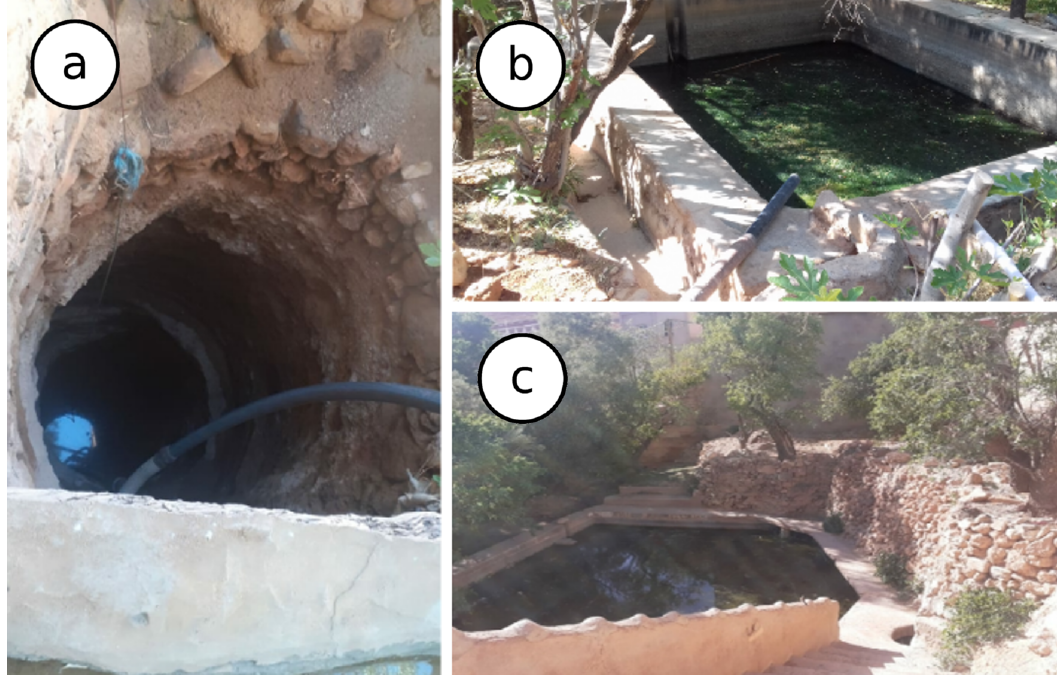
Figure A3. Nodes of the irrigation system. ( a ) A well with mechanical pump. ( b ) A modern and recent reservoir. ( c ) A traditional